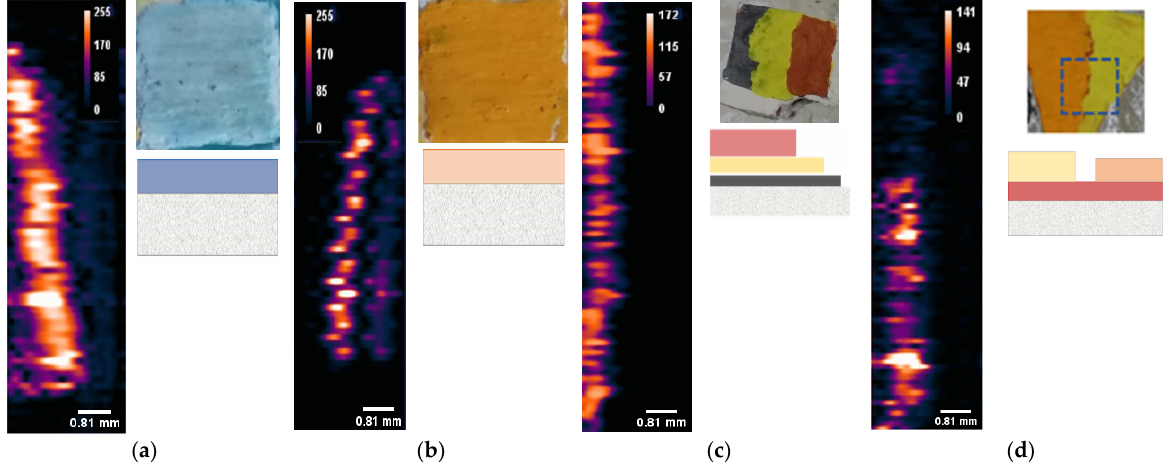
Figure 6. PA imaging of transverse view of ( a ) M02; ( b ) M07; ( c ) V02; ( d ) V03 samples with relative pictures and respective cross ‐ section sketches.